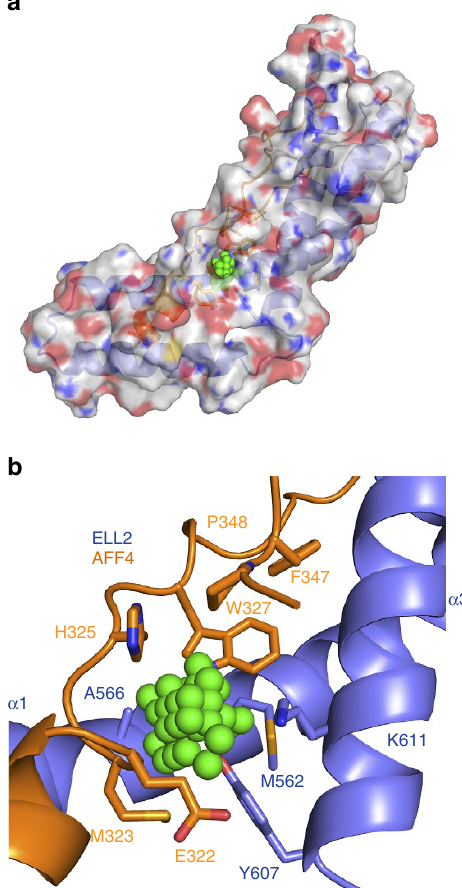
Figure 4 | Cavity at the AFF4 ELLBow –ELL2 Occ interface. ( a ) Overall view of the cavity that might work as a potential drug-binding site. Molecules of AFF4 ELLBow :ELL2 Occ complex are shown in translucent cartoon and surface model colours are light blue, ELL2; orange, AFF4; and green, dummy atoms ( b ) Close-up of the cavity region as represented and coloured in a